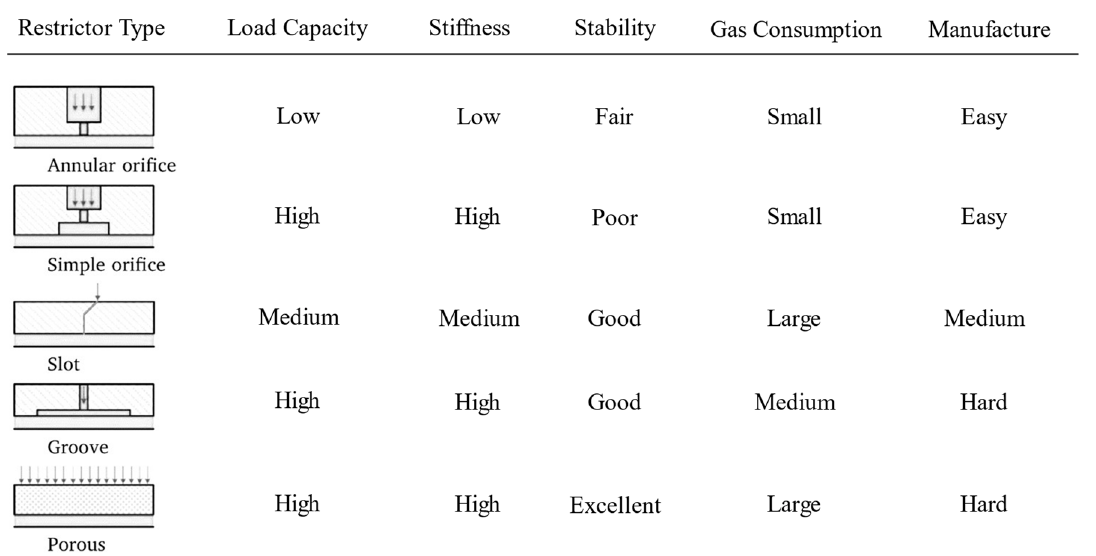
Figure 3. Characteristics of different types of restrictor types. Reprinted with permission from ref. [12]. Copyright 2019 Elsevier.